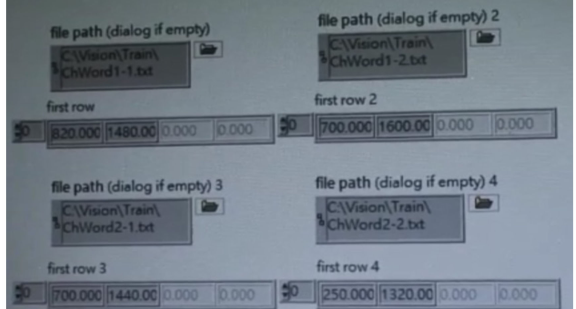
Figure 21. The original coordinate information.